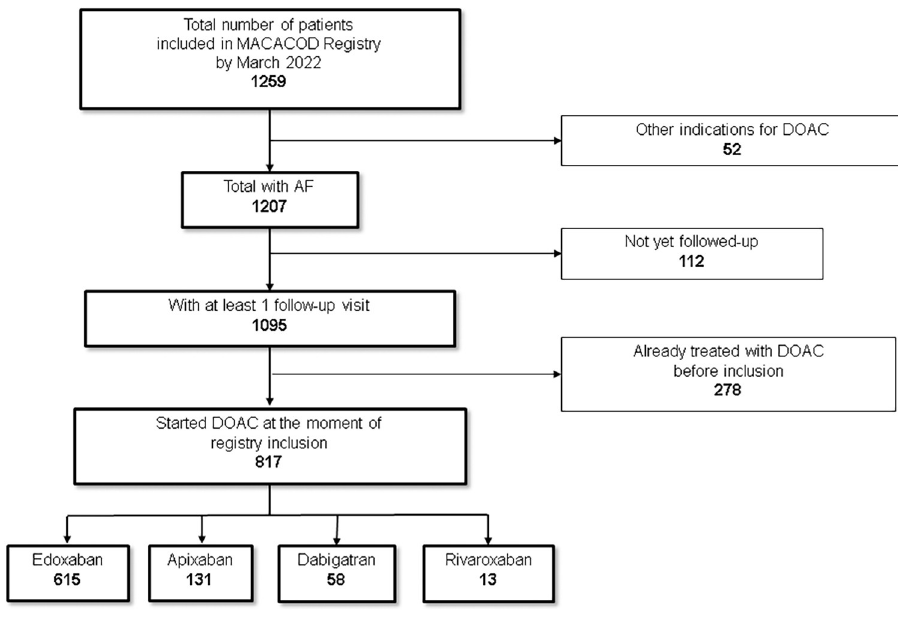
Fig 1. MACACOD patients’